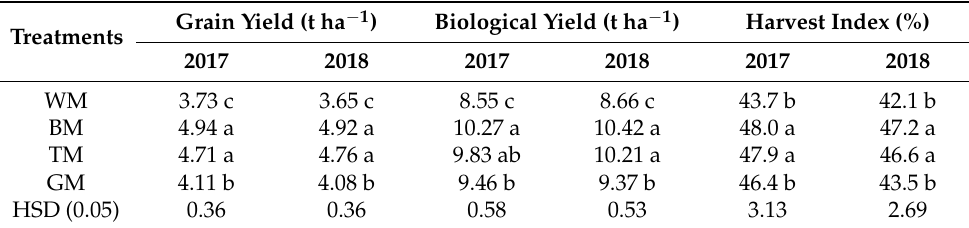
Table 2. Influence of different ridge-furrow mulches on grain yield (t ha − 1 ), biological yield (t ha − 1 ) and harvest index (%) of maize during 2017 and